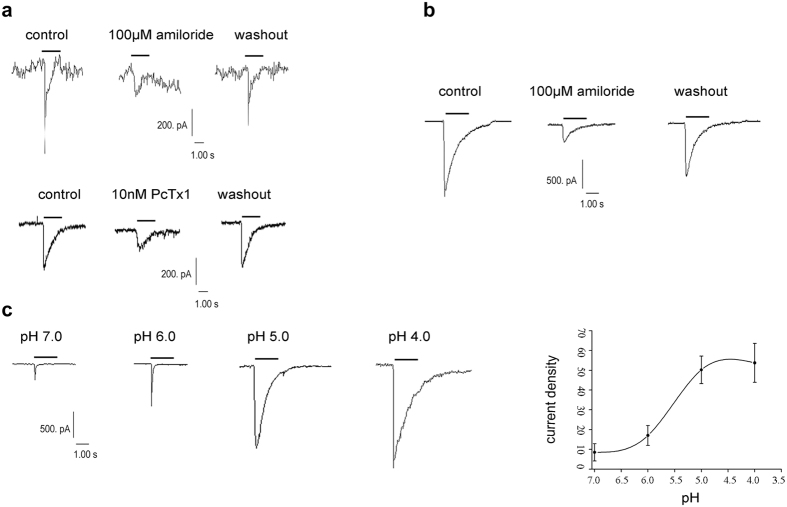
ASIC currents in cultured and acute isolated rat cardiomyocytes.(a) Representative ASIC-like currents inhibited by amiloride (100 μM, n = 3 cells) and PcTx1 (10 nM, n = 4 cells) in cultured rat cardiomyocytes. (b) Inhibition of ASIC-like currents by amiloride (100 μM, n = 3 cells) in acute isolated myocardiocytes of adult rat. (c) pH-dependent (upper) and pH-current density curve (lower) of ASIC currents in cultured rat cardiomyocytes. “—” indicates the duration of pH = 7.0, 6.0, 5.0 or 4.0 from 7.4. pH 7.0: 8.51 ± 4.37 pA/pF (n = 8 cells), pH 6.0: 17.03 ± 5.02 pA/pF (n = 11 cells), pH 5.0: 50.20 ± 6.94 pA/pF (n = 7 cells), pH 4.0: 53.73 ± 9.87 pA/pF (n = 7 cells). Each point represented as the mean ± s.e.m.